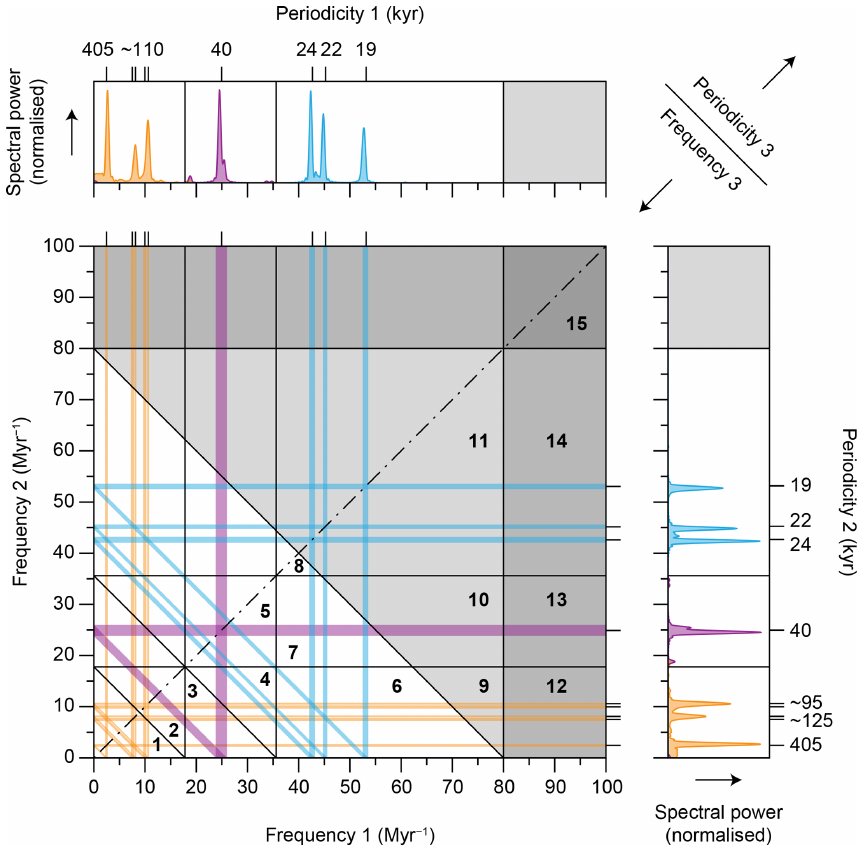
Figure 3. Bispectral zonation scheme. Bispectra of climate cycles can be subdivided into 15 zones that reflect unique combinations of three frequency bandwidths. Orange, purple, and blue lines represent the main astronomical frequencies of the eccentricity, obliquity, and preces- sion cycles, respectively (this colour coding is consistent throughout the paper). The grey shaded areas represent suborbital periodicities. Difference frequencies f 1 and f 2 are plotted along the along the horizontal and vertical axes, respectively. Sum frequencies f 3 (i.e. f 1 + f 2 ) are depicted as diagonal lines in the bispectrum. See also Table A1 for a list of bispectral zones and Table A2 for a list of triad types among the main astronomical frequencies in the